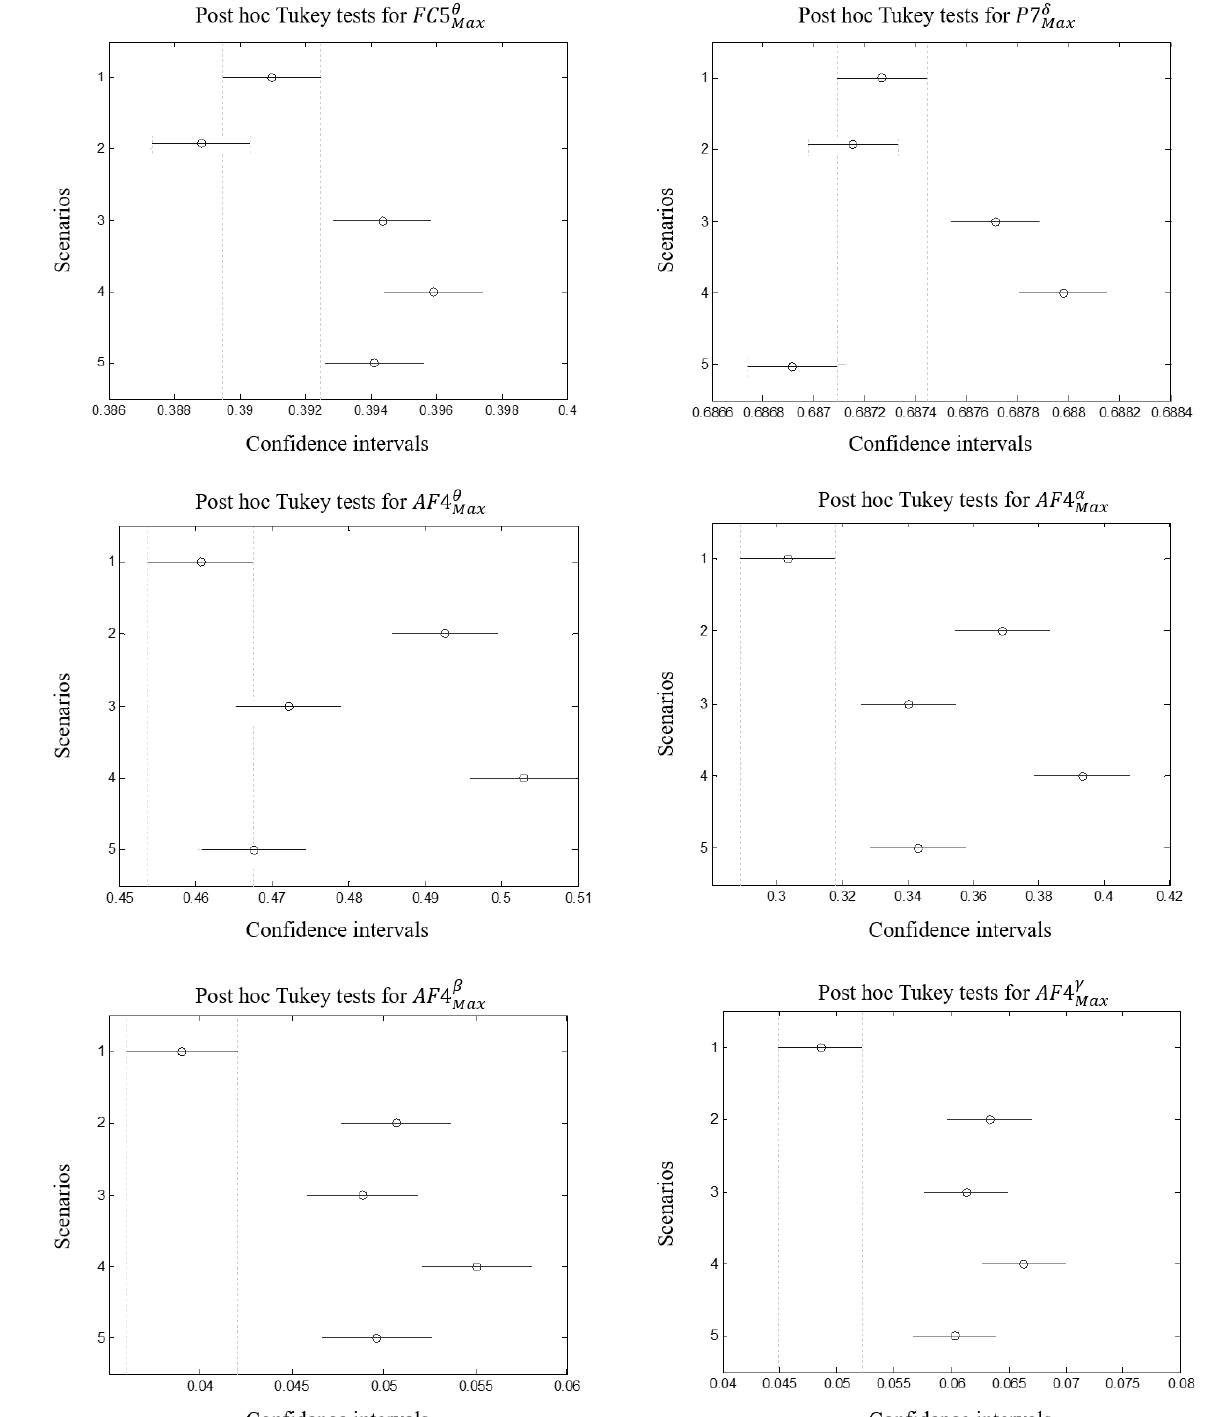
, P 7 δ , AF 4 θ , Max Max Max